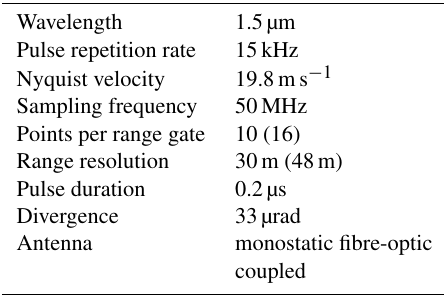
Table 1. Halo Photonics StreamLine and StreamLine XR hetero- dyne Doppler lidar specifications. Values in parentheses refer to the specification of the Doppler lidar during the first period in Darwin.